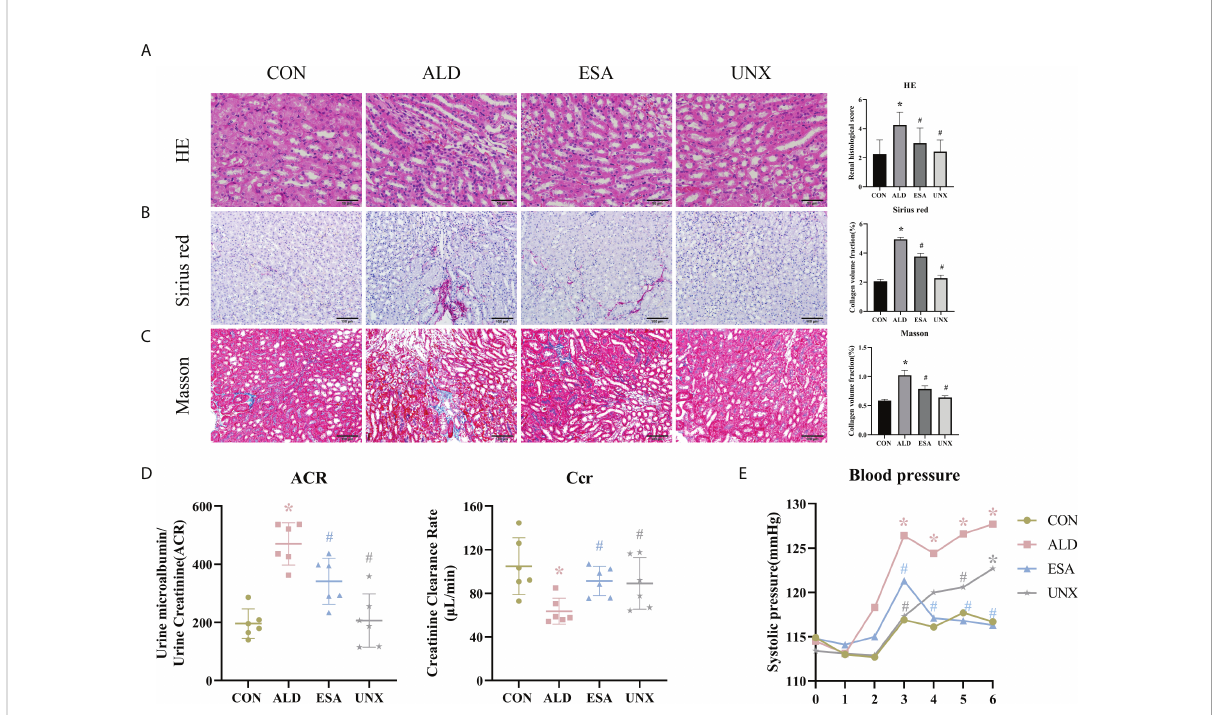
FIGURE 1 Changes in renal histology, fi brosis, and kidney function were reversed by ESA in UNX+ALD-infused mice. Kidney sections from the groups were stained with H&E to examine morphological changes and in fl ammatory cell in fi ltration (A) , Sirius red was used to examine collagen deposition (B) , and Masson was used to examine fi brosis (C) (n = 6). (D) ACR and Ccr were evaluated to determine renal function (n = 6). (E) Measurement of SBP (n = 10). The data are presented as the mean ± SD, *p < 0.05 vs. the CON group, # p < 0.05 vs. the ALD group. ESA, esaxerenone; UNX, uninephrectomy; ALD, aldosterone; ACR, urine microalbumin to urinary creatinine ratio; Ccr, creatinine clearance; SBP, systolic blood